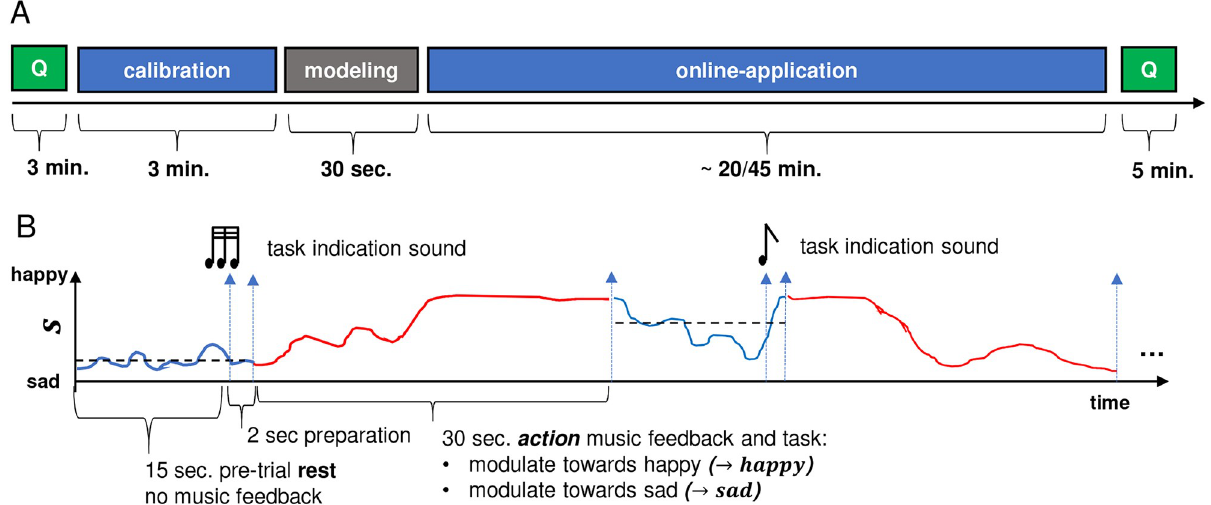
Fig 4. BCI study experiment protocol (A) and trial structure (B). (A) Each session began with a questionnaire, followed by a calibration phase and subsequent modeling of the emotion classifier. Afterwards, the main part of the experiment, the online application phase, was conducted. The experiment ended with a second questionnaire. (B) A single trial started with a resting period of 15 sec in which no music feedback was presented to the participant. The participant‘s EEG was recorded in the background, and the average score was used to assign, on every trial, one of the two tasks (modulate towards happy or sad) to the participant. The subject then performed the task for a duration of 30 sec (action period).